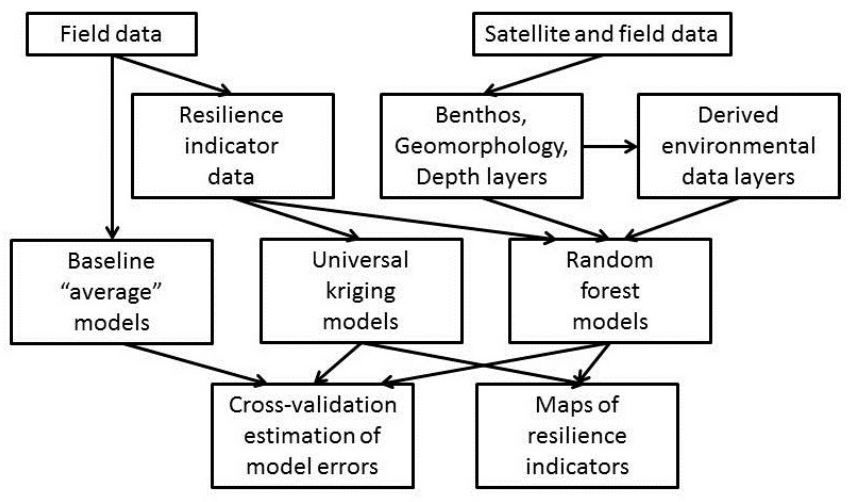
Figure 2. Flow chart of the data processing chain used to create the environmental data layers, the predictive models, error estimates and the maps of each resilience